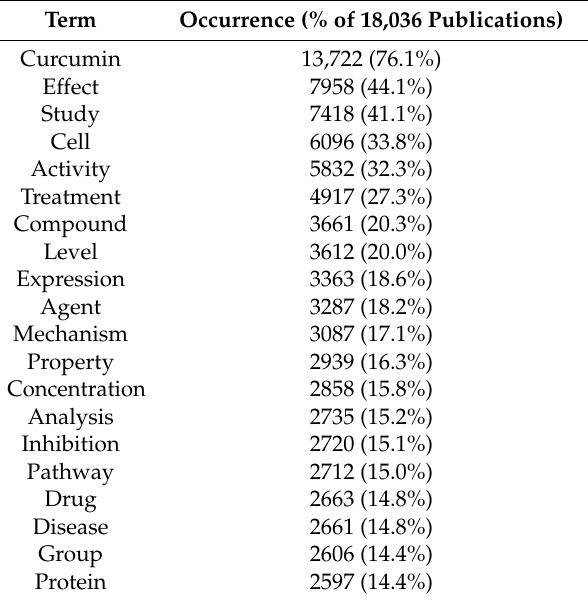
Figure 1. Bubble map visualizing words from titles and abstracts of the 18,036 curcumin publications. We used VOSviewer software to analyze and visualize recurring terms from titles and abstracts. Only words that appeared in at least 1.0% ( n = 181) of the publications were analyzed and visualized. There were 422 terms that appeared in at least 1.0% of the evaluated publications. The word size indicates the appearance frequency of the words (multiple appearances in a single manuscript count as one). Two words are closer to each other if they co-occurred more frequently in the evaluated publications. Bubble colors represent the averaged citations of the terms. Table 2. The top 20 recurring terms from titles and abstracts.